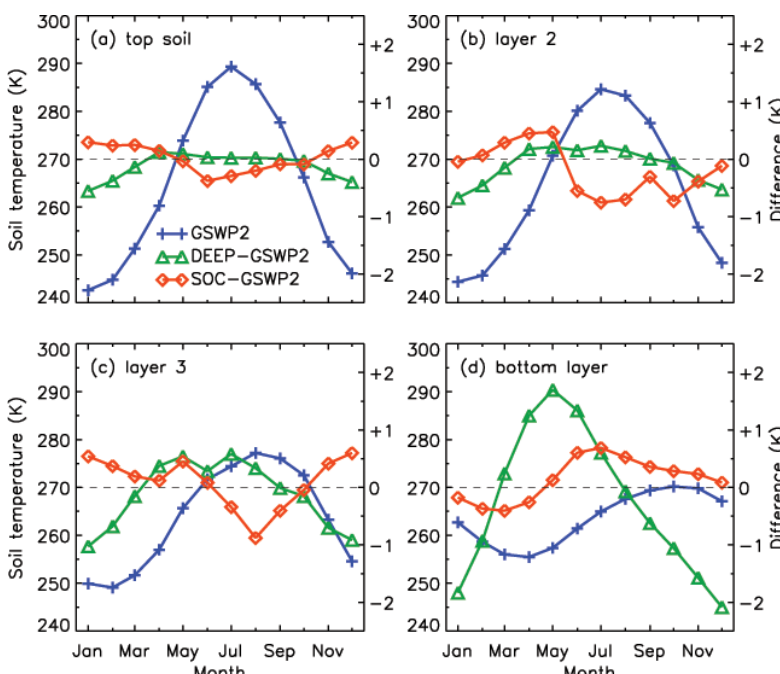
Fig. 6. Simulated mean soil temperature in GSWP2 (standard JULES) and difference with GSWP2 in the DEEP (extended soil profile) and SOC (modified soil parameters) experiments, averaged over a permafrost area in Siberia (110–135 ◦ E, 60–70 ◦ N): (a) top soil layer (0–10cm); (b) layer 2 (10–35cm); (c) layer 3 (35–100cm); (d) bottom layer (100–300cm). Note the temperature difference from GSWP2 in the DEEP and SOC runs is shown on the right-hand